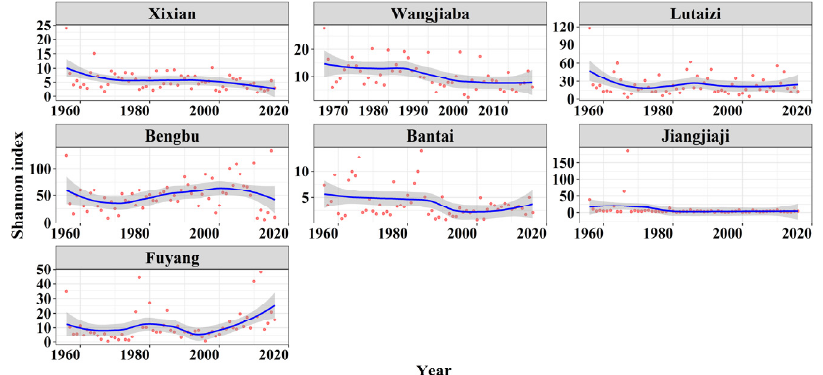
Figure 10. The trend change of Shannon index in the